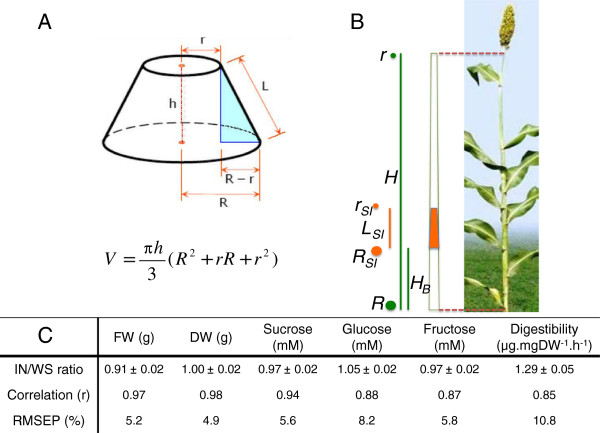
Extrapolating sampled biomass characteristics to whole stalks. (A)S. bicolor stalks were assumed to approximate a conical frustum allowing a simple volumetric calculation. (B) The fourth internode from the base of the plant that had expanded more than 2 cm was harvested and the height (H), stalk radius at the base (R) and top of the stalk (r), the height to the bottom of the fourth internode (HB), and the length of the fourth internode (L) were recorded. Fresh weight (FW), dry weight (DW), sucrose, glucose, and fructose concentrations of pressed juice and digestibility of the lignocellulose were measured in the fourth internode at approximately 10 days post-anthesis. Using the volumetric ratio (Vratio), these measurements were extrapolated to whole stalks and compared to equivalent measures taken from the same whole stalk. (C) The ratio of extrapolated fourth internode measures to whole stalks (IN/WS ratio), their correlation (r), and the error in prediction (RMSEP, %) are tabulated. DW, dry weight; FW, fresh weight; RMSEP, root mean squared error of prediction.